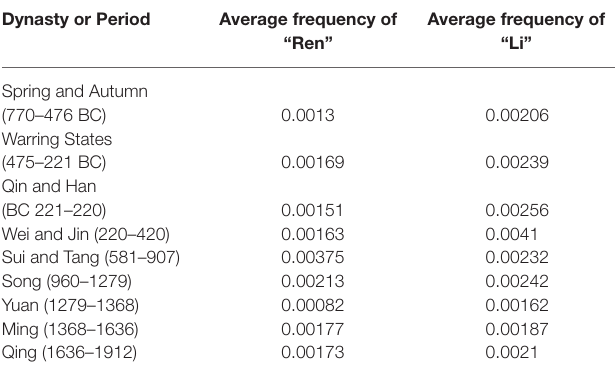
TABLE 2 | Average frequency of each keyword in different dynasties and